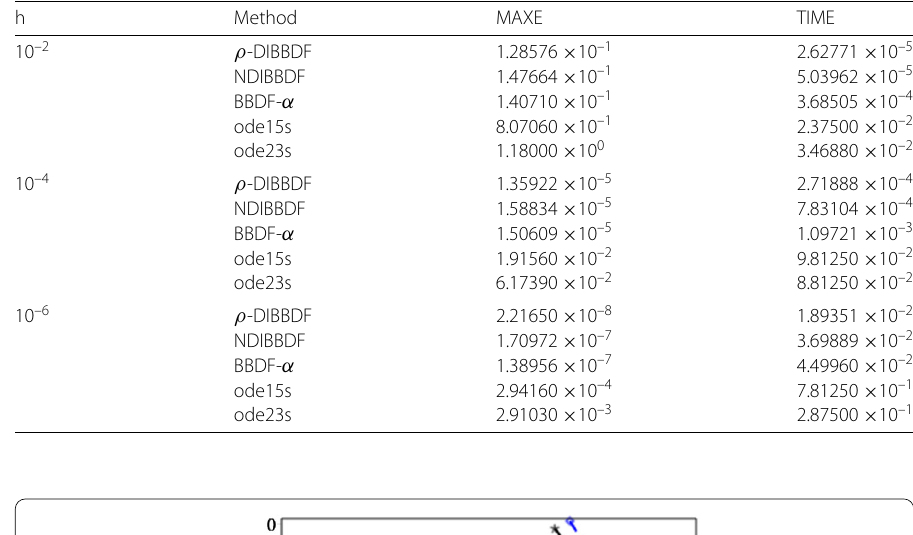
Table 9 Numerical results for concentration of drug in Model C(ii) h